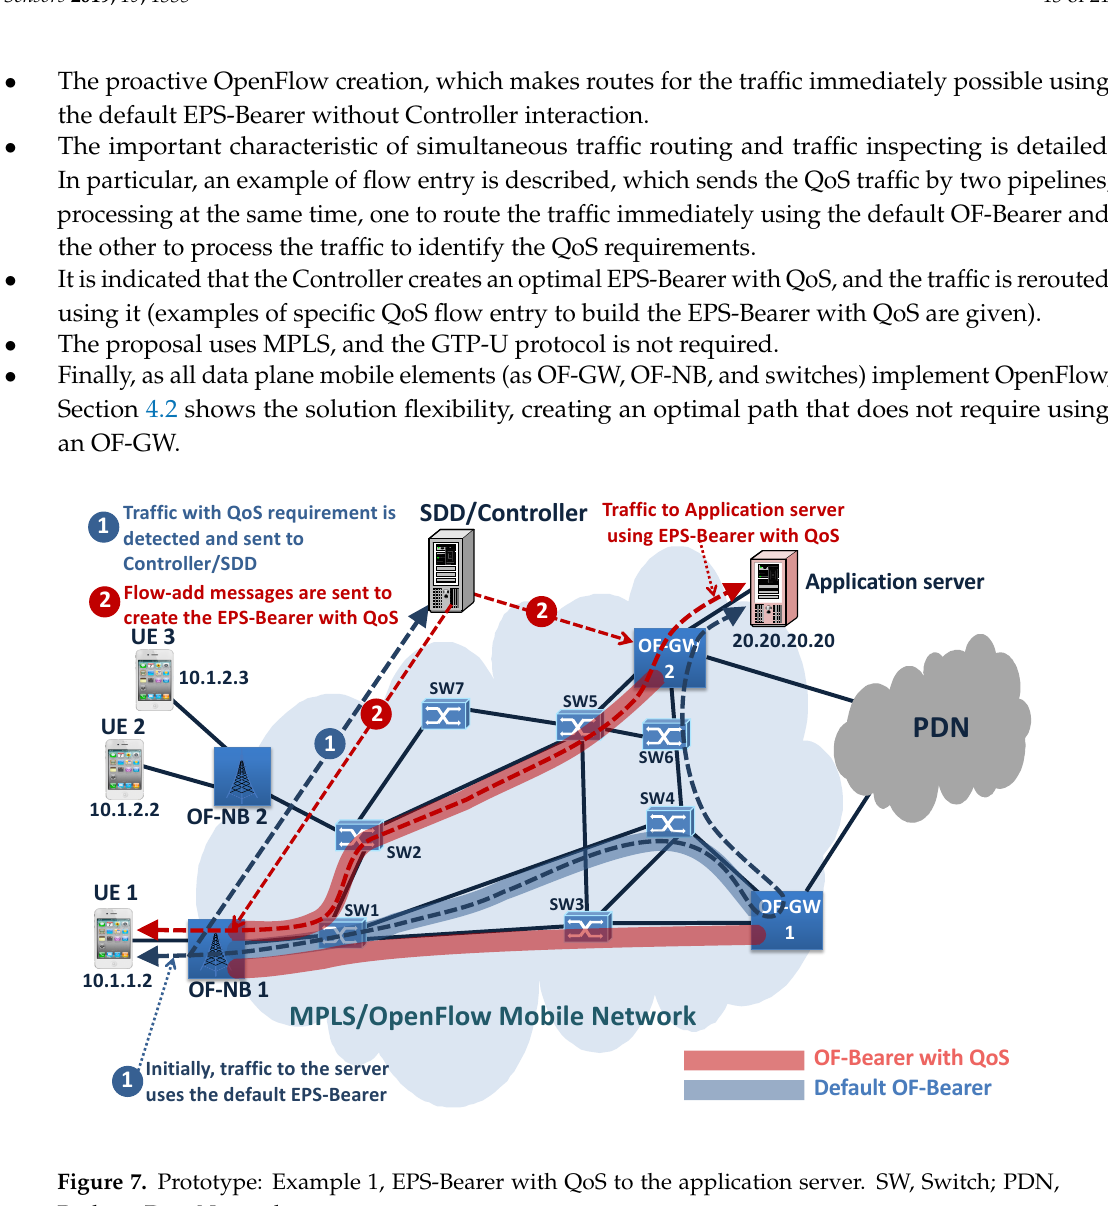
Figure 7. Prototype: Example 1, EPS-Bearer with QoS to the application server. SW, Switch; PDN, Package Data